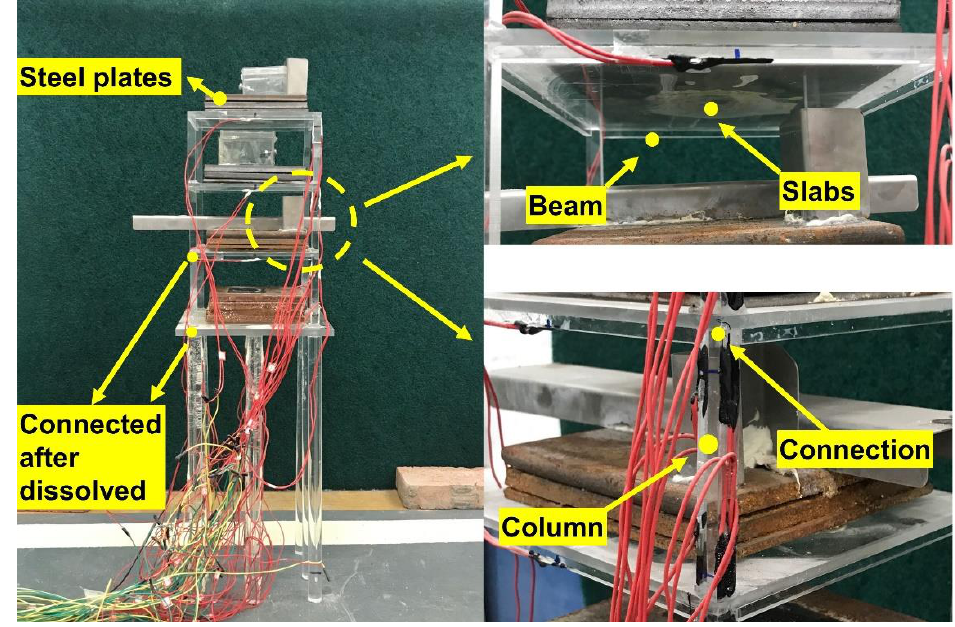
Figure 3. Model structure details.